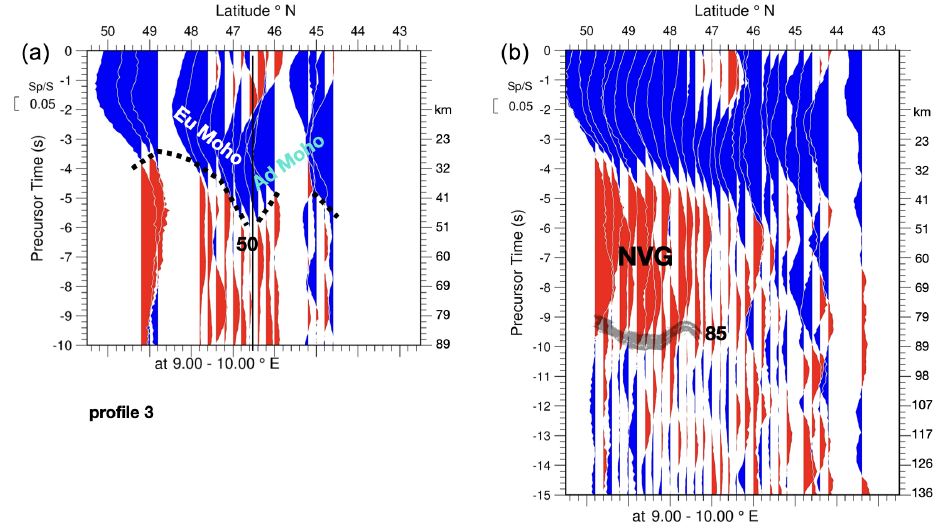
Figure 5. Profile 3. North–south profiles at 9–10 ◦ E. Note that the deepest point of the Moho at 46.5 ◦ latitude closely coincides with the Europe–Adria boundary according to Spada et al. (2013) (see Fig. 2).